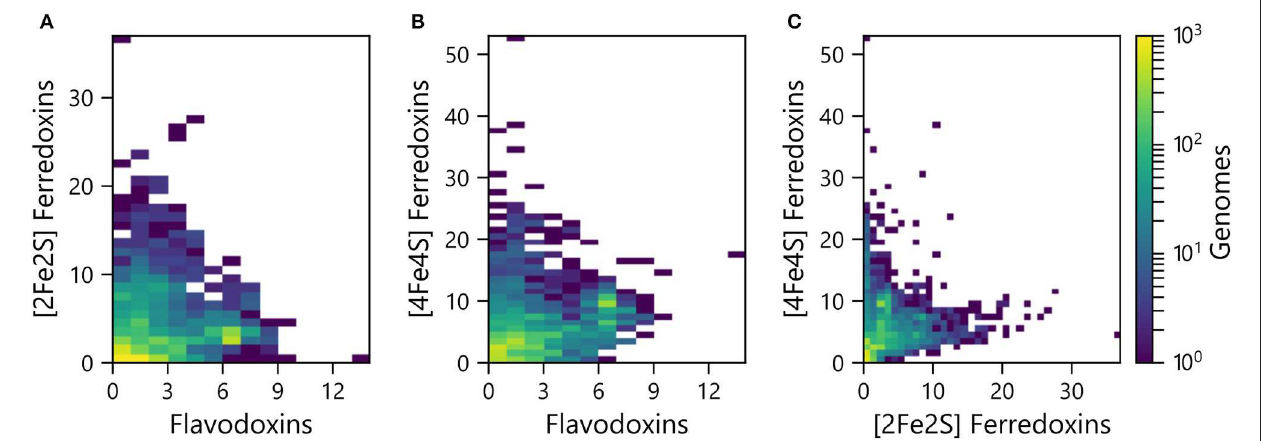
FIGURE 3 | Pairwise abundance of PEC genes within each genome. The abundances of (A) [2Fe-2S] Fd and Fld, (B) [4Fe-4S] Fd and Fld, and (C) [4Fe-4S] Fd and [2Fe-2S] Fd genes are plotted as heat maps. The density of organisms having each pairwise count is shown using a viridis color gradient.